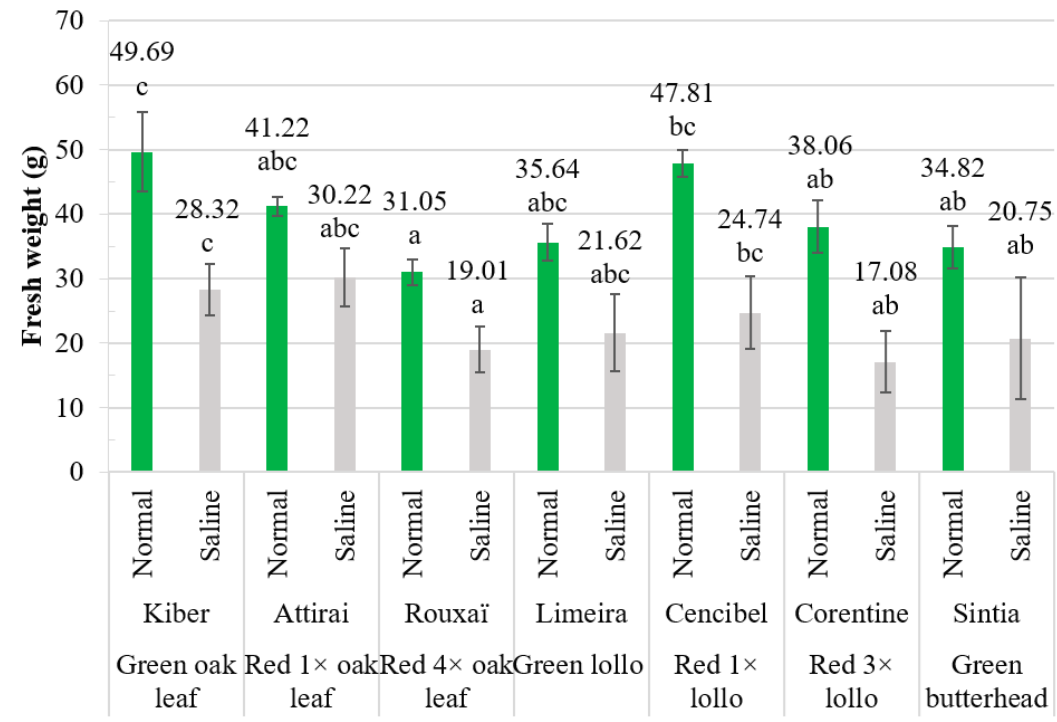
Figure 1. Fresh weight (FW) (g) of different cultivars of lettuce grown in high and normal electrical conductivity (EC) conditions 35 days after sowing. (Different letters indicate significant differences among the treatments at p < 0.05 by Tukey-Kramer’s test.